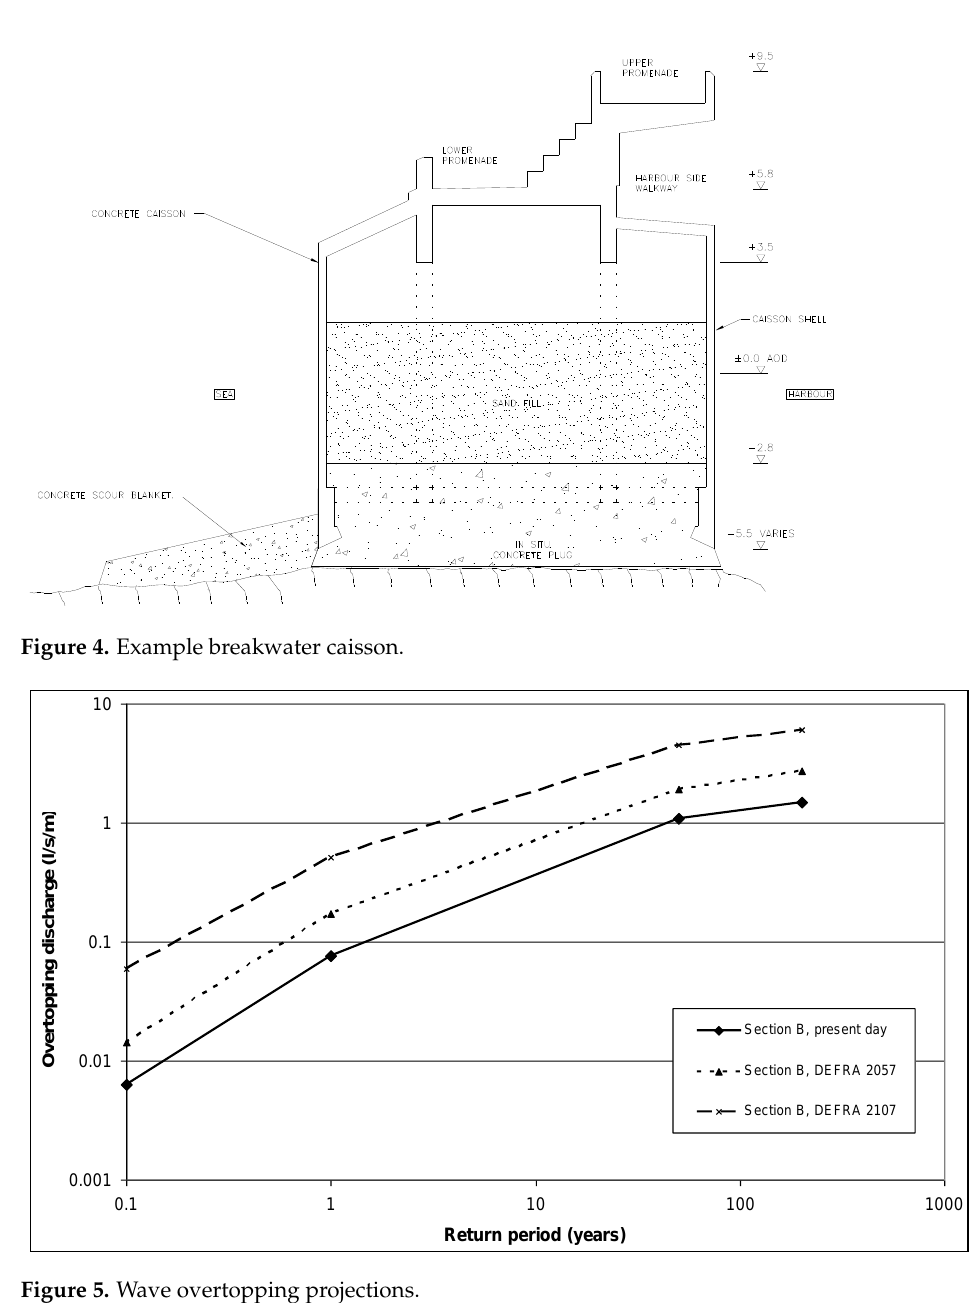
Figure 5. Wave overtopping projections.